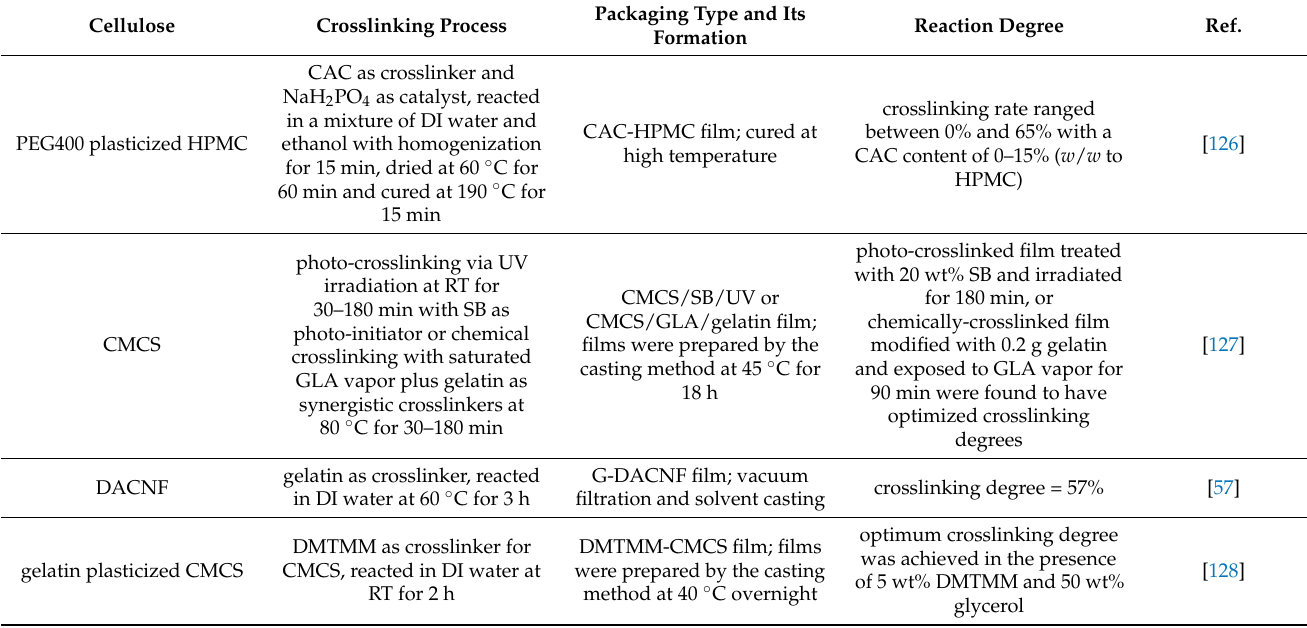
Table 8. Crosslinking of cellulose derivatives, reaction degree, and the associated packaging forming